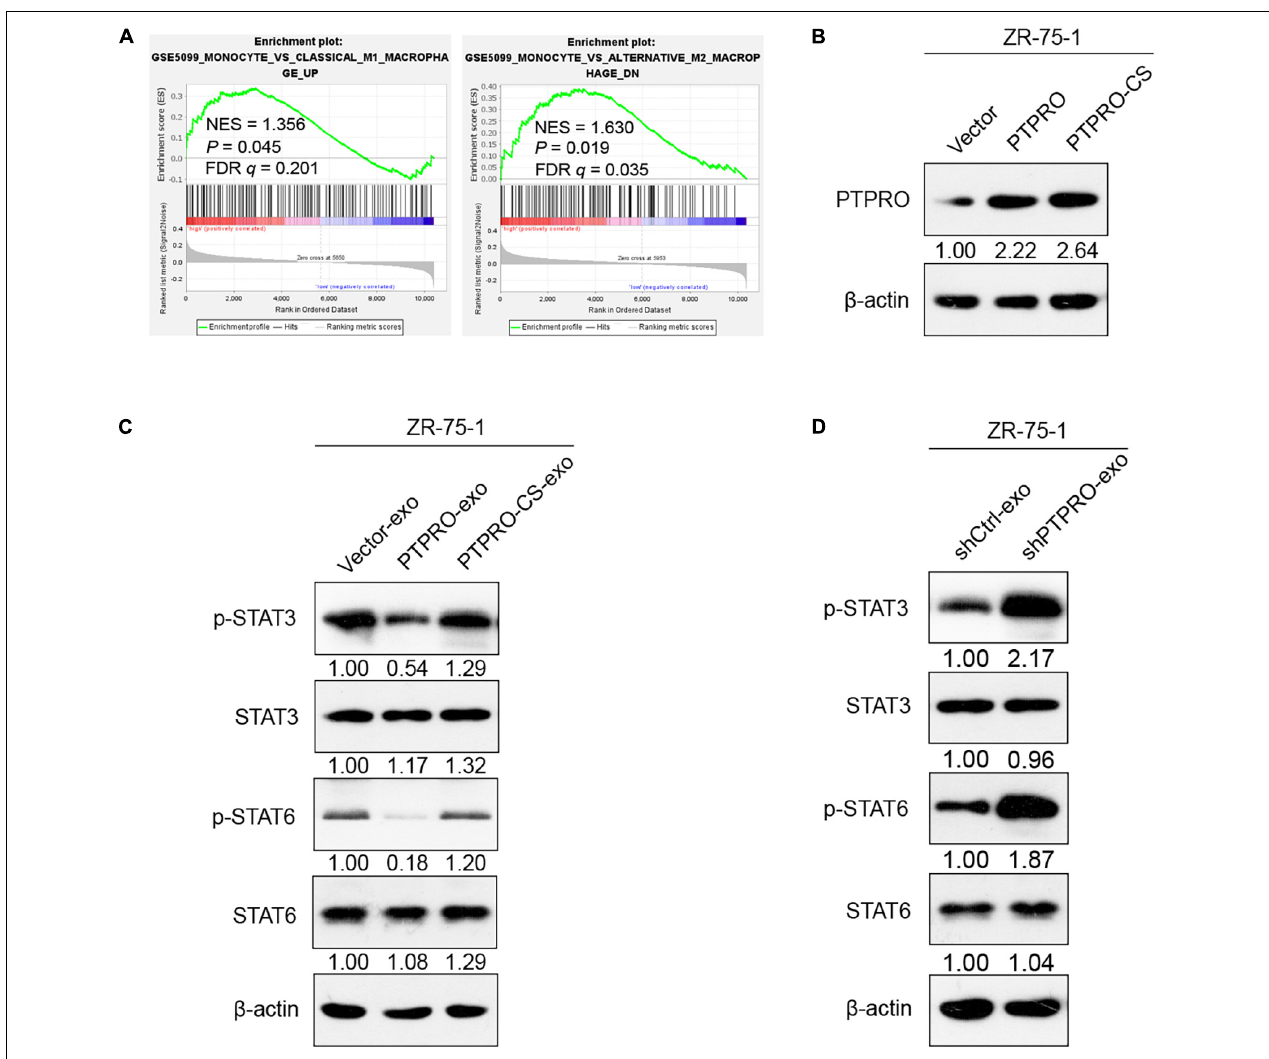
FIGURE 5 | Tumor cell-derived exosomal PTPRO polarized the M1 macrophage via dephosphorylated STAT3/STAT6 signaling. (A) GSEA showing inverse correlation between STAT3 expression and M1-gene signature (MONOCYTE_VS_CLASSICAL_M1_MACROPHAGE_UP) and positive correlation between STAT6 expression and M2-gene signature (MONOCYTE_VS_ALTERNATIVE_M2_MACROPHAGE_DN) in a published cohort of breast cancer. (B) Immunoblotting revealed that PTPRO was efficiently over-expressed in ZR-75-1 cells and the mutation of PTPRO did not affect it’s protein expression level. Relative protein expression was normalized to β -actin. (C) The expressions of STAT3/STAT6 protein and corresponding phosphorylated protein in THP-1 derived macrophage after treating with ZR-75-1-vector-exo, ZR-75-1-PTPRO-exo or ZR-75-1-PTPRO-CS-exo. Relative protein expression was normalized to β -actin. (D) The expressions of STAT3/STAT6 protein and corresponding phosphorylated protein in THP-1 derived macrophage after treating with ZR-75-1-shCtrl-exo or ZR-75-1-shPTPRO-exo. Relative protein expression was normalized to β -actin. FDR q , false-discovery rate q -value; NES, normalized enrichment